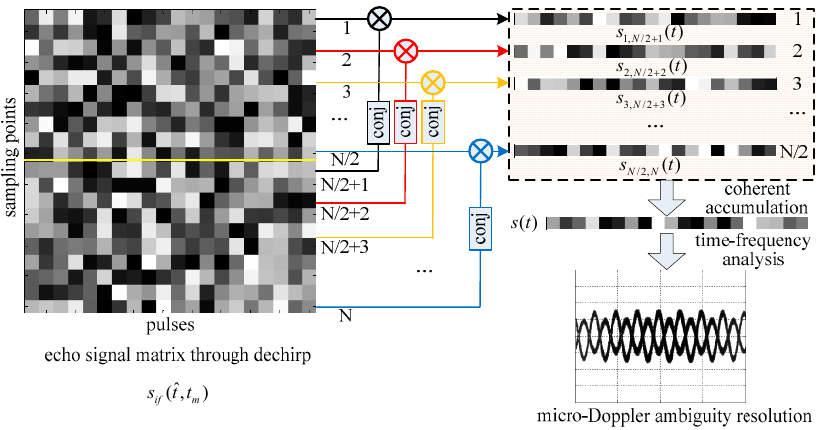
Figure 1. Schematic diagram of the micro ‐ Doppler ambiguity resolution method.